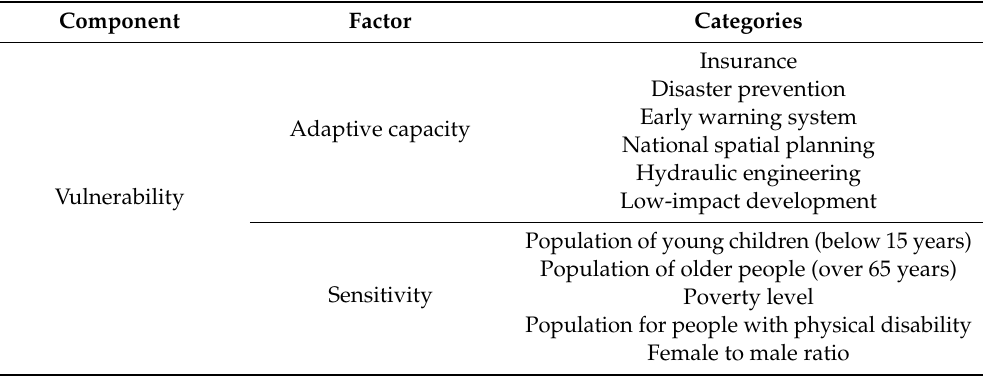
Table 3. The corresponding indicators of vulnerability considered in this